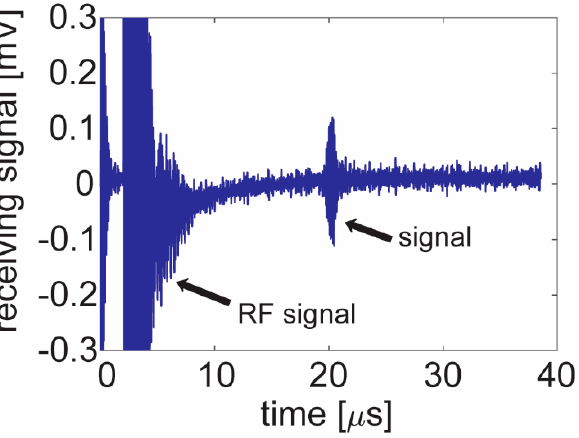
Figure 4. Pitch–catch testing of two neighboring 100 µm × 1000 µm single elements transmitting and receiving an acoustic signal reflected from a metal reflector at a 1.5 cm distance. The transmitting element was driven by a 5 V p 5-cycle unipolar excitation and the receiving element detected a 0.2 mV signal.